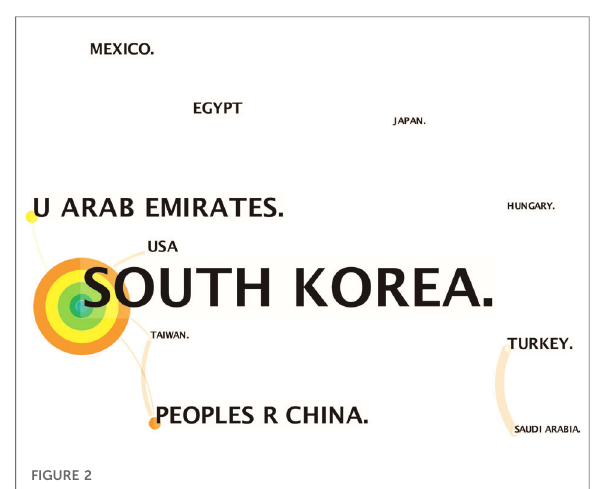
FIGURE 2 Co-operation network of the productive